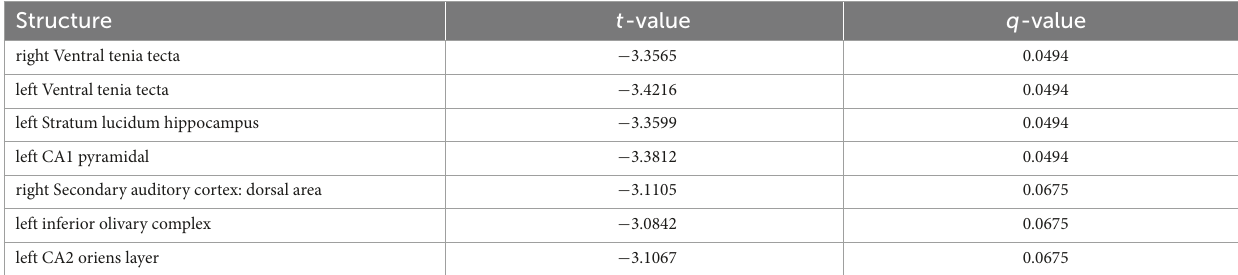
TABLE 2 Brain structures showing a decrease in volume following 7,8-DHF